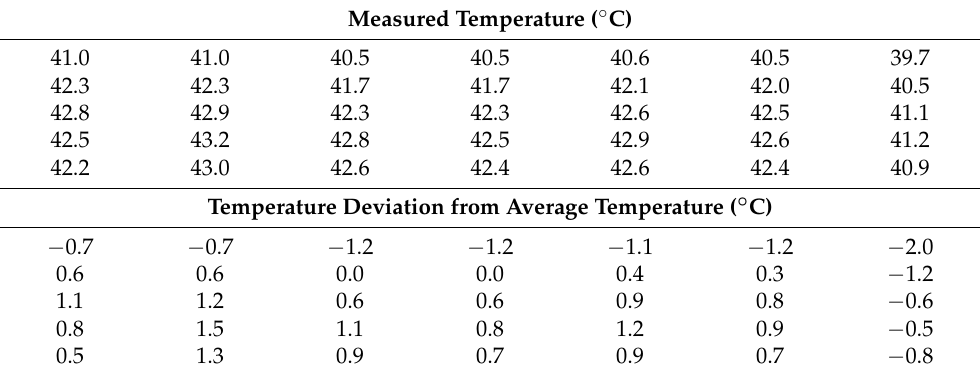
Figure 12. Heating temperature uniformity across the PTC-SHT at an applied voltage of 3 V. Table 2. Deviation of the measured temperature in each zone from the average temperature of the PTC-SHT (41.7 ◦